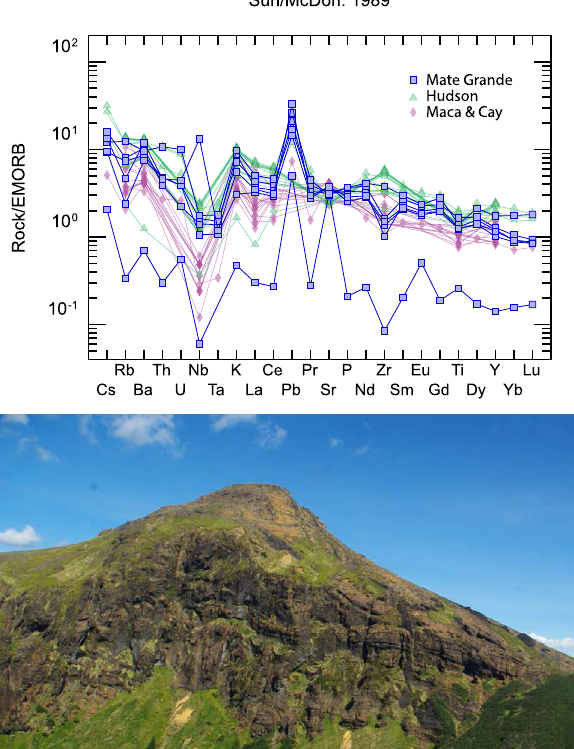
Figure 4. At top is an enriched Morb normalized spider diagram with samples from VMG. Intermediate samples with MgO contents between 2 and 4 of Hudson, Macá and Cay volcanoes were selected for comparison between the volcanoes. Note the distinct signature of the VMG versus the nearby other major stratovolcanoes 33,34 . At bottom is an oblique helicopter photo taken in January 2016 of the VMG during field reconnaissance. Please note the mafic nature of the stratified volcanic rocks here (consistent with the spider plot above) and flow bands that formed during VMG eruptions. Field photograph by R. Hermanns. Please see Supplemental Information for additional field